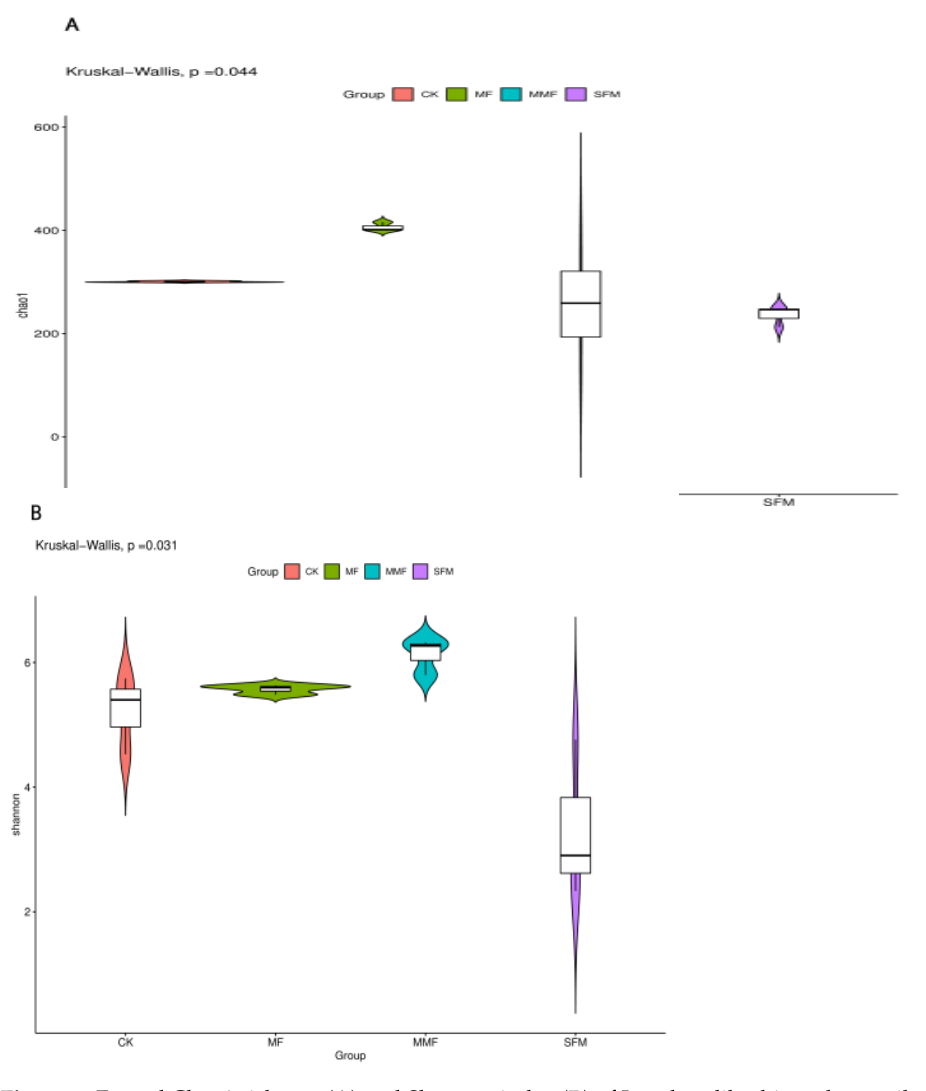
Figure 1. Fungal Chao1 richness ( A ) and Shannon index ( B ) of Lanzhou lily rhizosphere soil among different treatments from Illumina NovaSeq data.